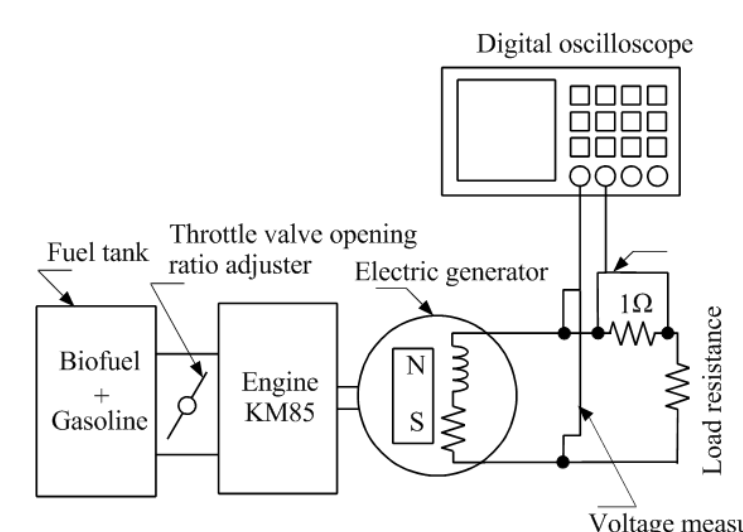
Figure 4. Experimental measurement